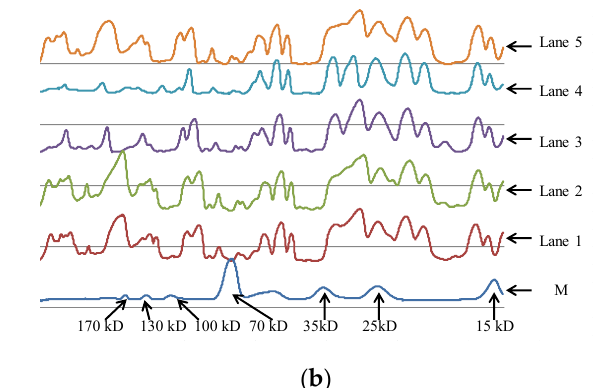
Figure 1. Sodium dodecyl sulfate–polyacrylamide gel electrophoresis (SDS–PAGE) and optical density of pork muscle protein. ( a ) is SDS–PAGE image of the five breeds of pork; ( b ) is the optical density (O.D.) of SDS-PAGE image; MBP, manor black pigs; TBP, Tibetan black pigs; PPP, Pipa pigs; YNP, Yihao native pigs; WP, white pigs; M, marker; lanes 1, 2, 3, 4, and 5 are the protein expression patterns of the muscles from MBP, TBP, PPP, YNP, and WP, respectively.